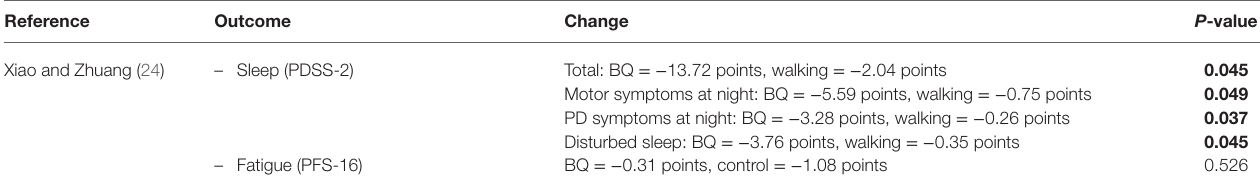
Instrument abbreviations: UPDRS, Unified Parkinson’s Disease Rating Scale; BDI, Beck Depression Inventory; MMSE, Mini Mental State Examination; HDRS, Hamilton Depression Rating Scale; ESS, Epworth Sleepiness Scale; NMSS, Non-Motor Symptom Scale; PFS-16, Parkinson’s Fatigue Scale-16 Questions; SAS, Starkstein Apathy Scale; PDSS-2, Parkinson’s Disease Sleep Scale Version 2; MoCA, Montreal Cognitive Assessment; KFSS, Krupp’s Fatigue Severity Scale; AS, Apathy Scale; LARS, Lille Apathy Rating Scale; PaSMO, Parallele serial mental operations; FSS, Fatigue Severity Scale; HADS, Hospital Anxiety and Depression Scale; BTA, Brief Test of Attention. Significant values are in bold. # Marks intra group P-value; NS, non-significant; N/A, not available. Negative score indicates improvement: UPDRS-1, BDI, HDRS, ESS, PFS-16, SAS, PDSS-2, KFSS, AS, LARS, PaSMO, FSS HADS, Stroop test time, and trail making. Positive score indicates improvement: MMSE, NMSS, MoCA, BTA, digit span, Stroop test score, letter verbal fluency, categorical verbal fluency, text recall, symbol digit modification, Clox and Cube, and naming 30